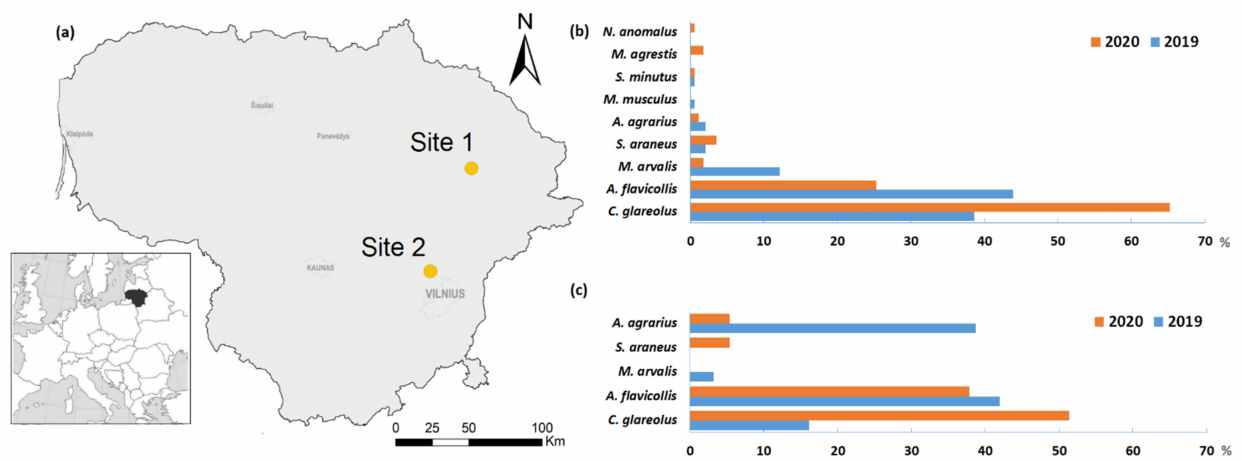
Figure 1. Location of the study sites in Lithuania ( a ): Site 1, homestead (55.444 N, 25.464 E), Site 2, kitchen garden (54.822 N, 25.104 E), and compositions of the small mammal community in 2019 and 2020 at Site 1 ( b ) and Site 2 ( c